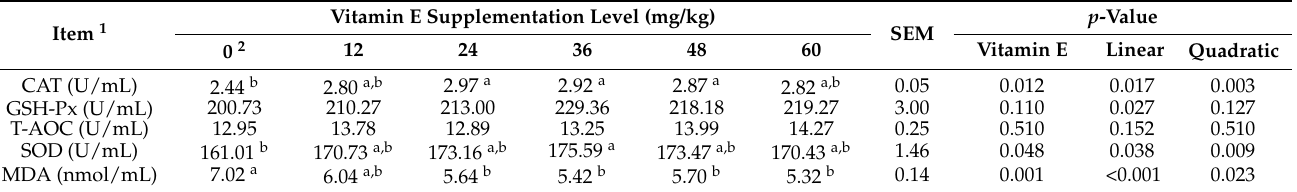
Table 6. Effect of dietary vitamin E supplementation on the antioxidant capacity in the serum of male Jiangnan white goslings on day